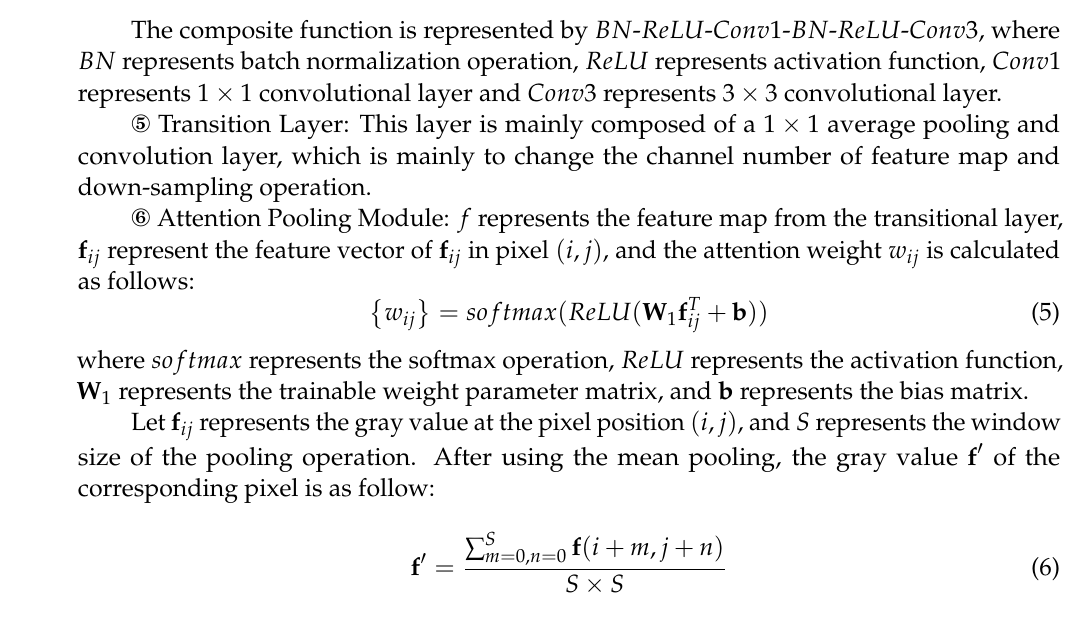
Figure 7. The principle of dense